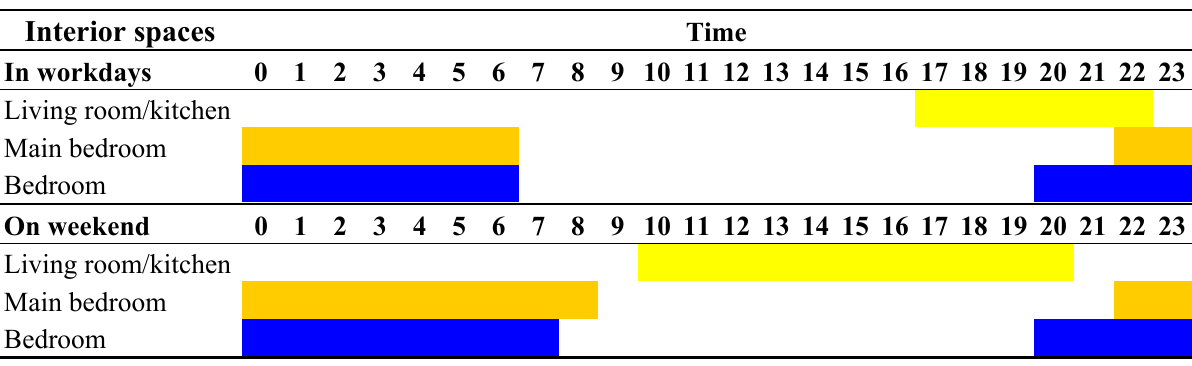
Table 4. Daily occupation period of major spaces (00:00 to